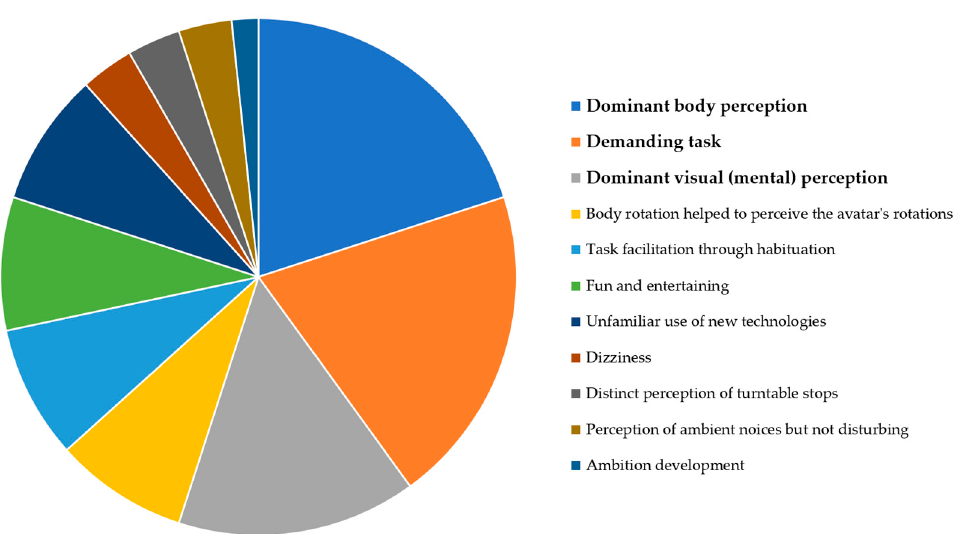
Figure 3. Results of the qualitative content analysis of the students’ answers during the feedback session. A total of eleven aspects have been identified, which summarize the content of the students’ feedback. The dominant perception of one’s own body during the VR rotation task, which largely led to irritation, the perception of the task as demanding, and the dominant visual perception were mentioned the most in the feedback session.